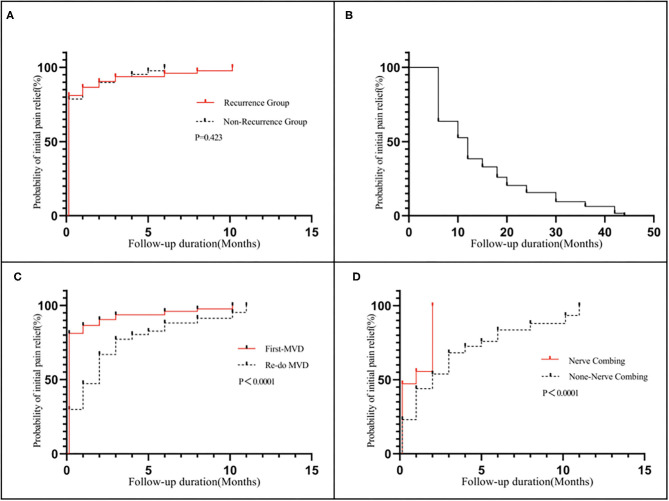
Kaplan–Meier analyses: (A) Revealed that although the non-recurrent group experienced initial pain relief earlier than the recurrent group after MVD, the results were not statistically significant (log-rank test, p = 0.423): (B) shows a median pain-free survival of 12 months after the first MVD procedure; (C) Revealed that the redo MVD group experienced initial pain relief later than the first-onset group after MVD, and the results were statistically significant (log-rank test, p < 0.05); (D) Revealed that the nerve combing group experienced initial pain relief earlier than the non-nerve combing group after MVD, and the results were statistically significant (log-rank test, p < 0.05).